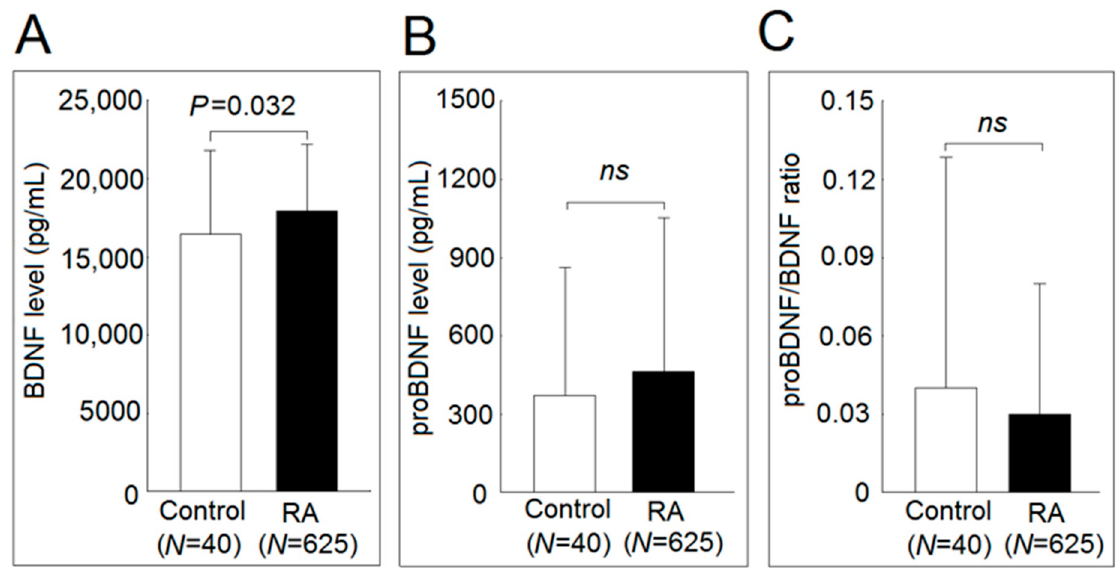
Figure 1. Serum brain-derived neurotrophic factor (BDNF), the precursor form of BDNF (proBDNF) concentration, and proBDNF/BDNF ratio in healthy controls and patients with rheumatoid arthritis. Serum levels of ( A ) BDNF, and ( B ) proBDNF concentration and ( C ) proBDNF/BDNF ratio in 40 healthy controls and 625 patients with rheumatoid arthritis. Serum levels of BDNF and proBDNF were measured by enzyme-linked immunosorbent assay (ELISA). After adjusting for age and sex in the multiple linear regression analysis, the BDNF levels remained significantly ( p = 0.033) elevated in serum from patients with rheumatoid arthritis compared with those from controls. ( ns not significant; * p < 0.05).